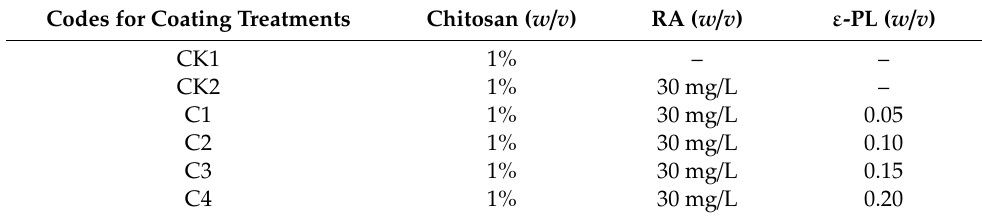
Table 1. The final concentrations of chitosan, rosmarinic acid (RA), and ε -polylysine ( ε -PL) in coating solutions. Codes for Coating